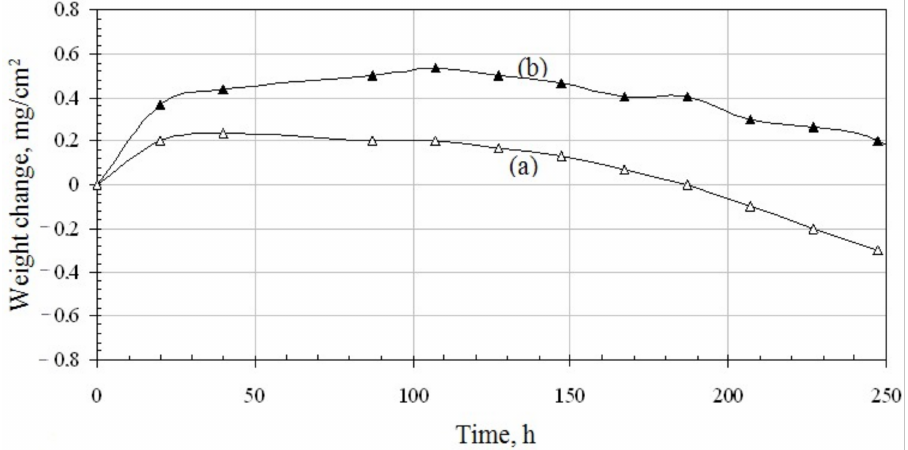
Figure 10. Weight change versus oxidation time of the palladium doped ( a ) and palladium and zirconium co-doped ( b ) aluminide